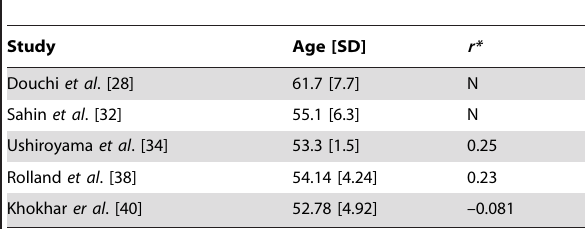
Table 4. r between LC and age in PW in the included